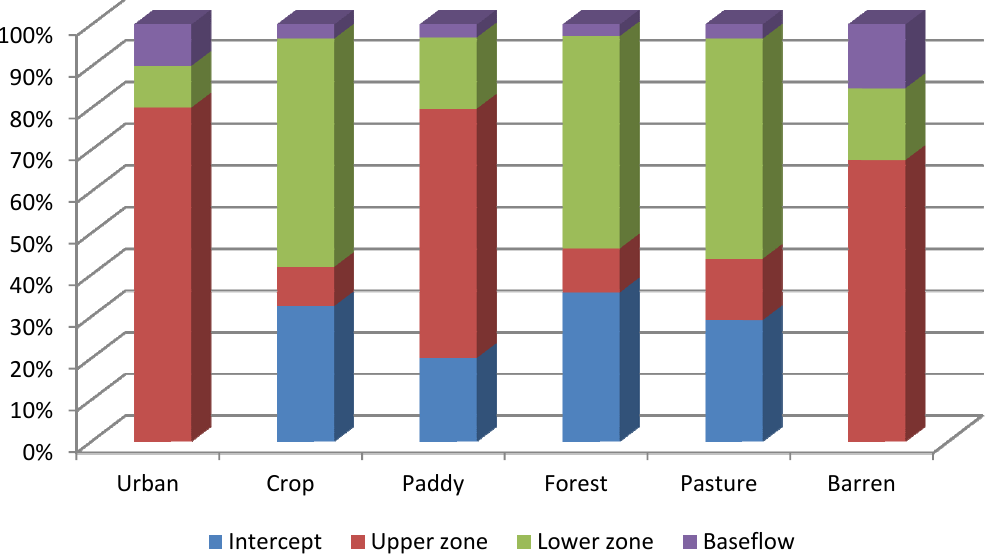
Figure 8. Comparison of rates of evapotranspiration components by land use type.